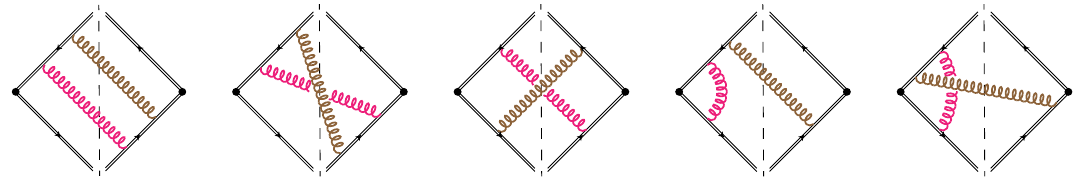
Figure 10 . Examples of abelian diagrams with one perturbative (magenta) CS gluon and a non- perturbative (brown) gluon. Dashed line represents measurement of the plus momentum along with the soft drop operator. Graphs with a virtual NP gluon are not